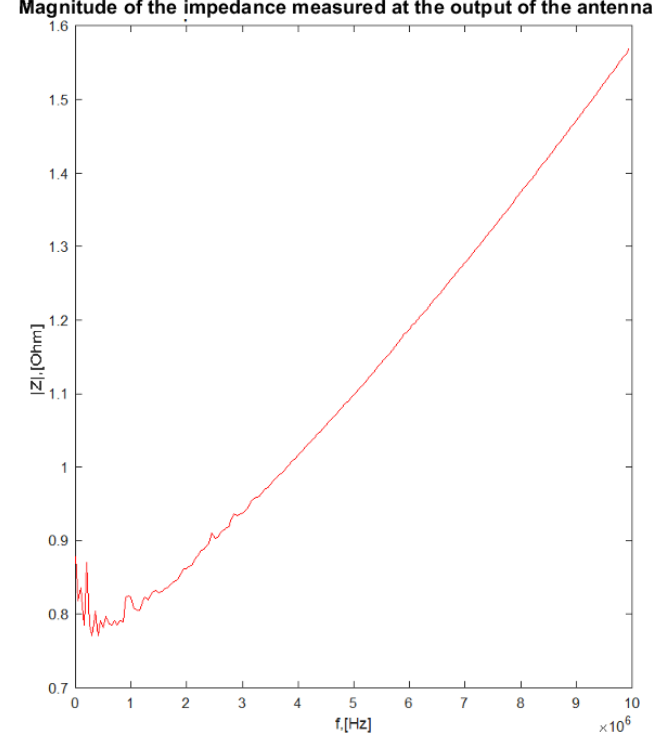
Figure 18. Linear characteristics of the impedance of the output of the antenna as a function of frequency.